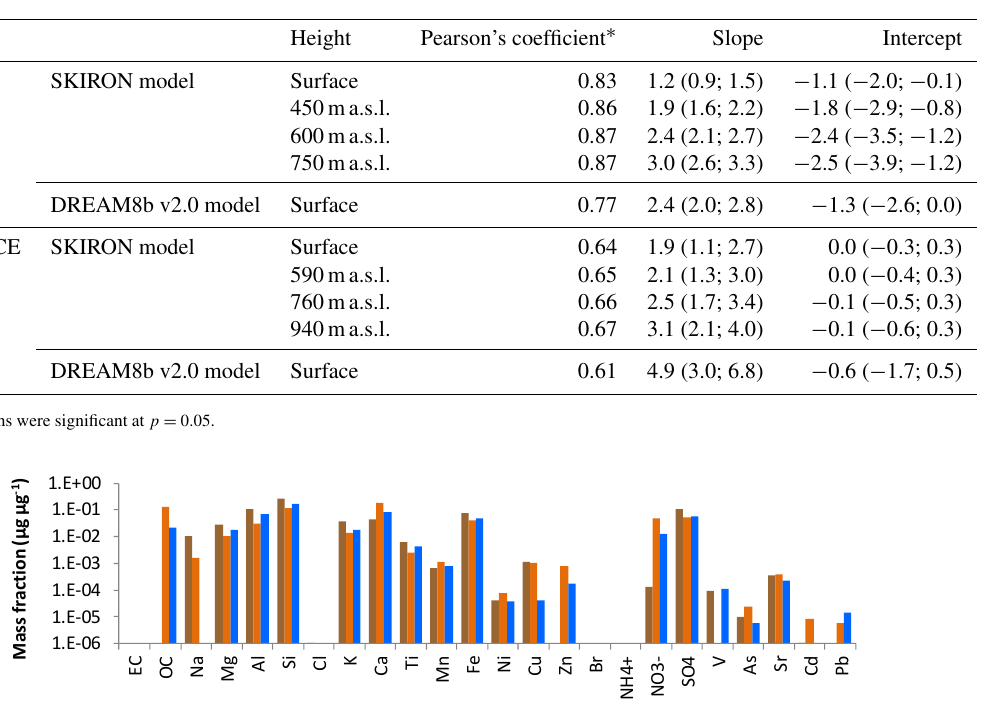
Table 4. Deming regression analysis of dust loads predicted by transport models versus the net dust concentration calculated: (i) through regional PM 10 concentration data for Athens and (ii) by PMF analysis for Florence. The lower and upper bounds at the 95% confidence interval for the calculated slopes and intercepts are presented in parentheses.